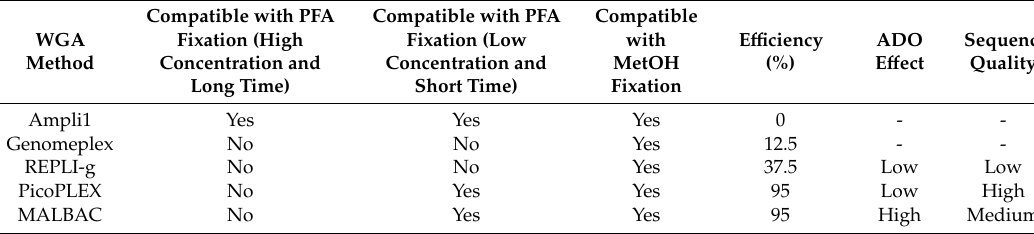
Table 1. Table summarizing the characteristics and the compatibility of WGA